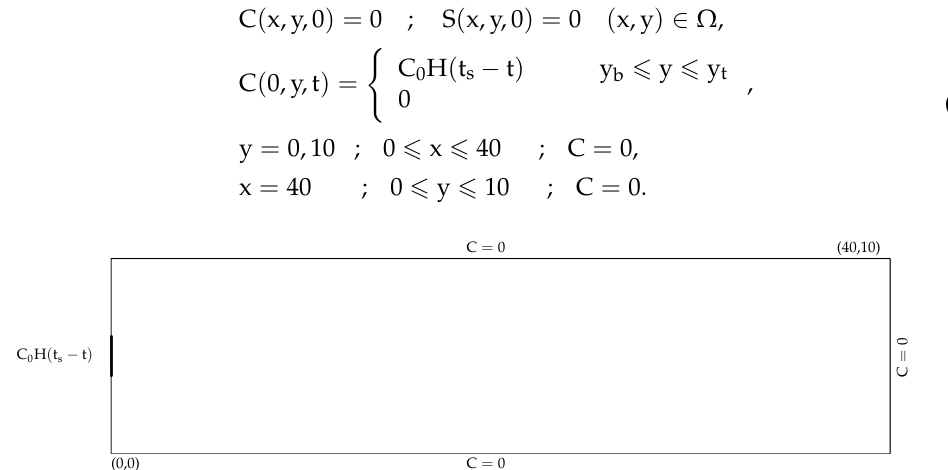
Figure 3. The aquifer domain for the analytical solution.